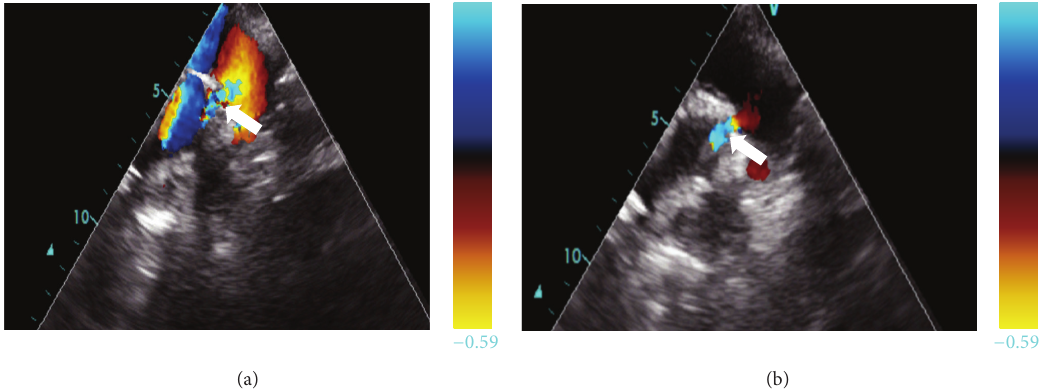
Figure 3: Colour doppler images from the transthoracic echocardiogram show right-to-left shunt through the subaortic VSD (arrow).